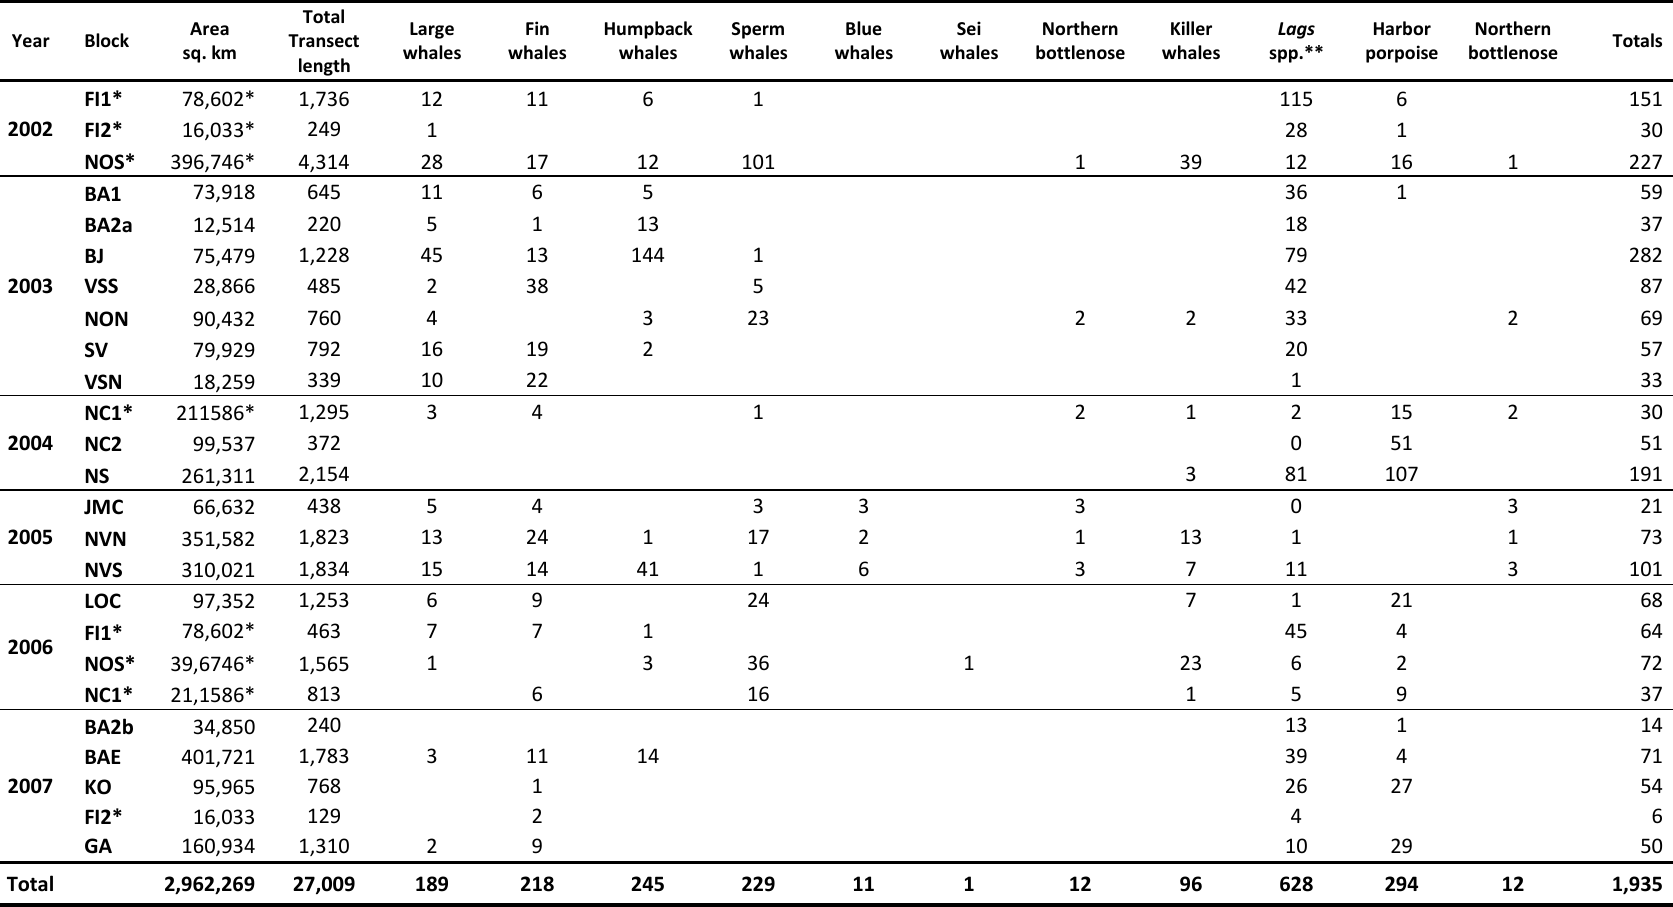
Table 2. Summary of effort and sightings for the 2002 – 2007 survey for each species by survey block and